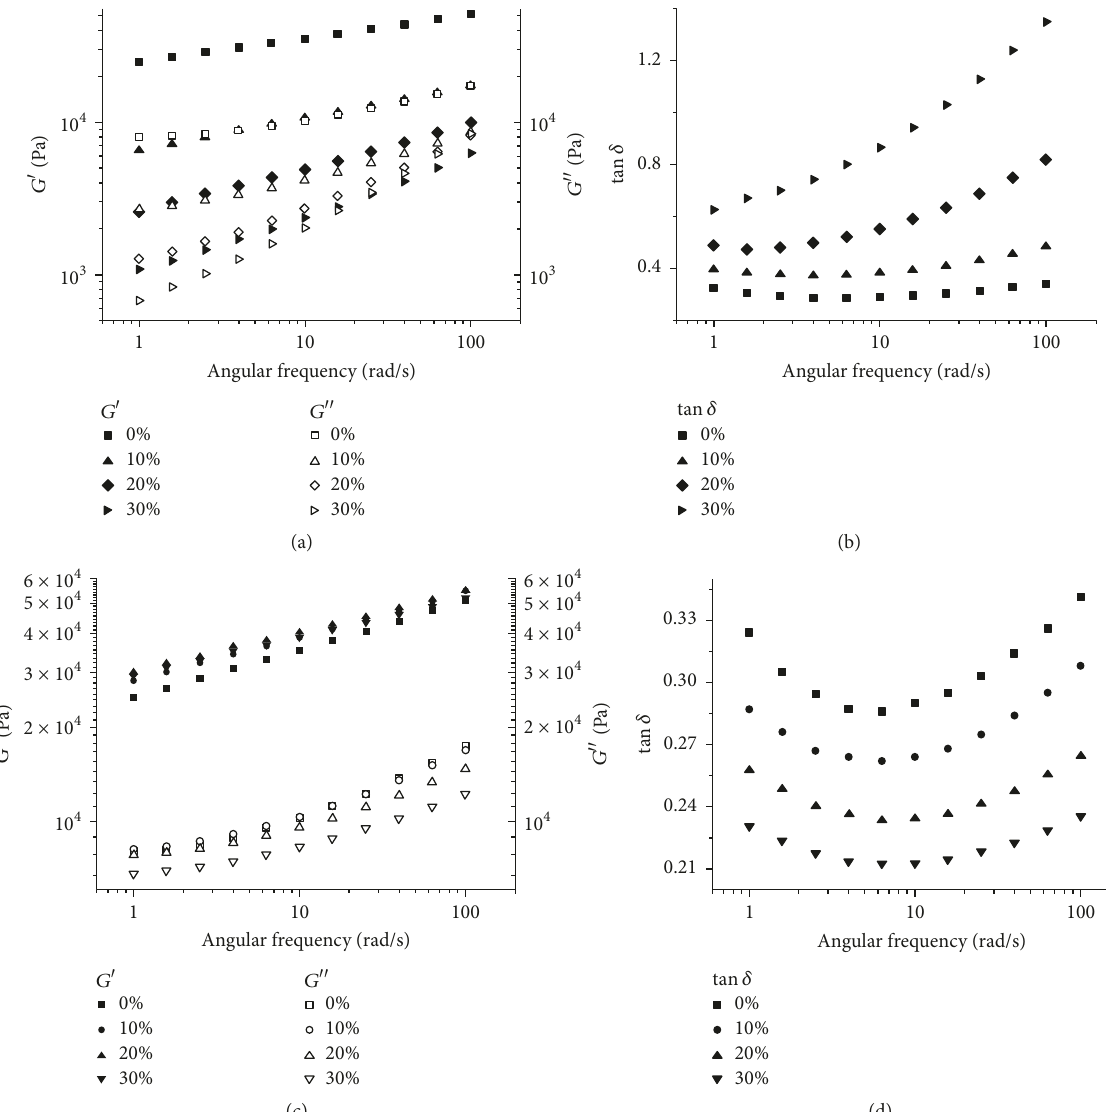
Figure 1: The effect of whey and soy protein addition on 𝐺 󸀠 , 𝐺 󸀠󸀠 , and tan 𝛿 of wheat dough with frequency sweep: WP ((a), (b)); SP ((c), (d)).